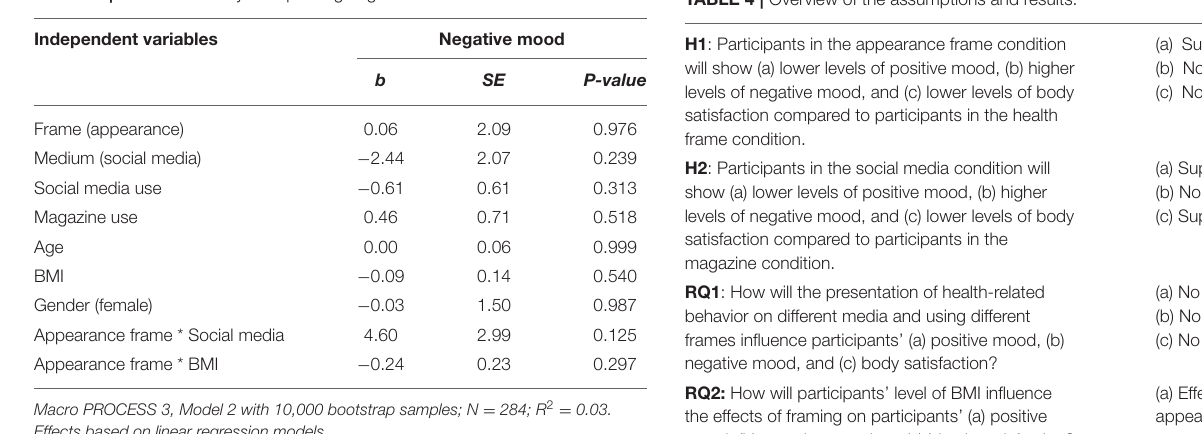
TABLE 2 | Moderated analysis explaining negative mood.